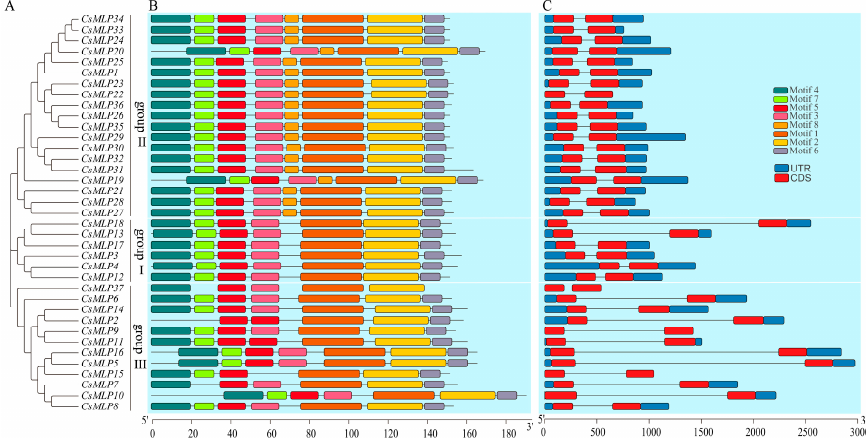
Figure 3. Phylogenetic tree, gene structure, and schematic representation of the conserved motifs in deducing CsMLP proteins. ( A ) the phylogenetic tree of 37 CsMLP proteins. ( B ) the motif compositions of CsMLP genes. ( C ) exon/intron architectures of CsMLP genes. Exons and introns are represented by red and blue rectangles, respectively. Upstream/downstream regions are indicated by black